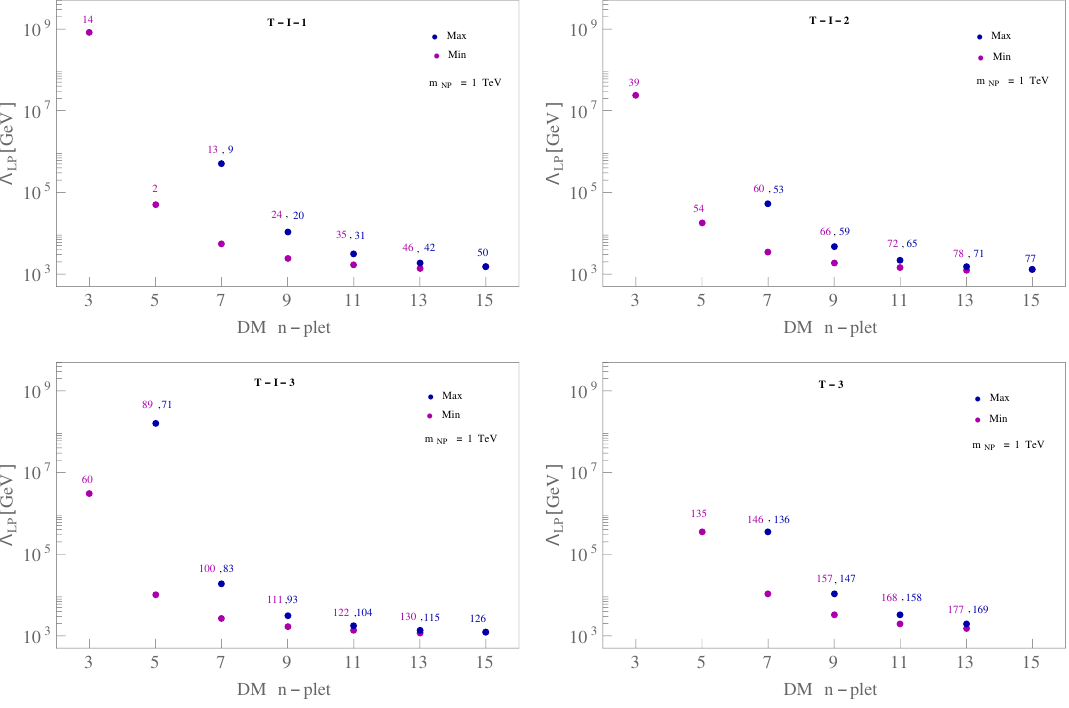
and its specific 2